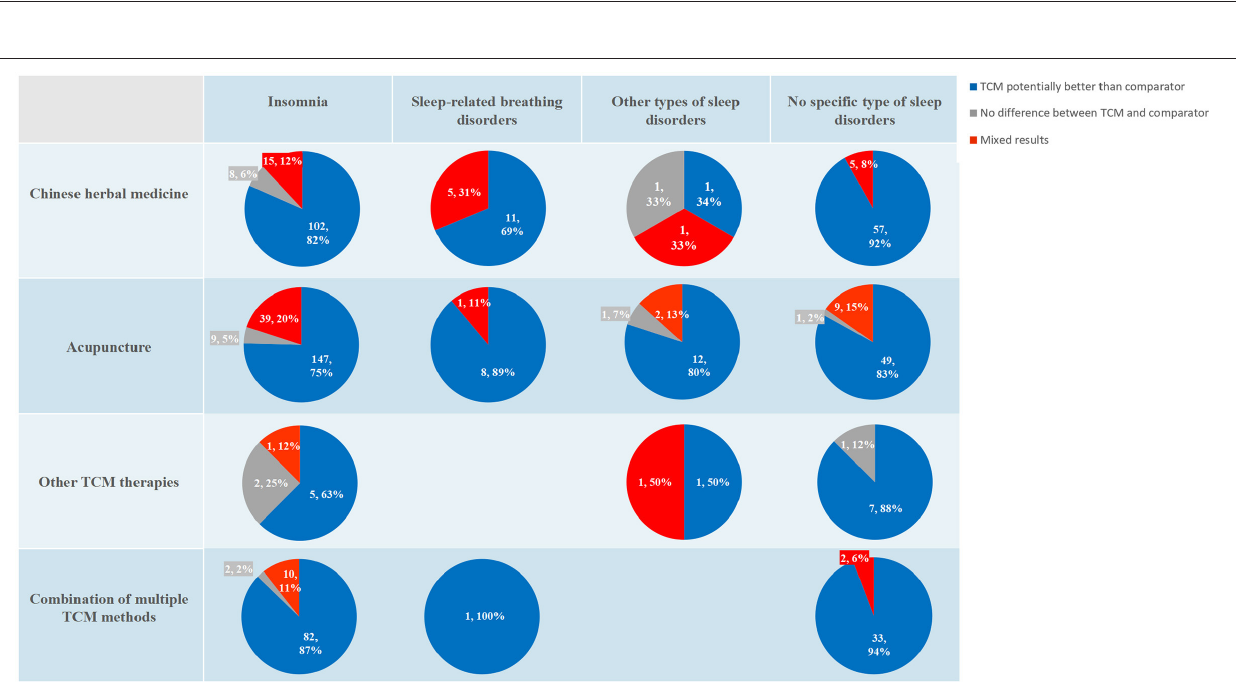
Frontiers in Psychiatry |